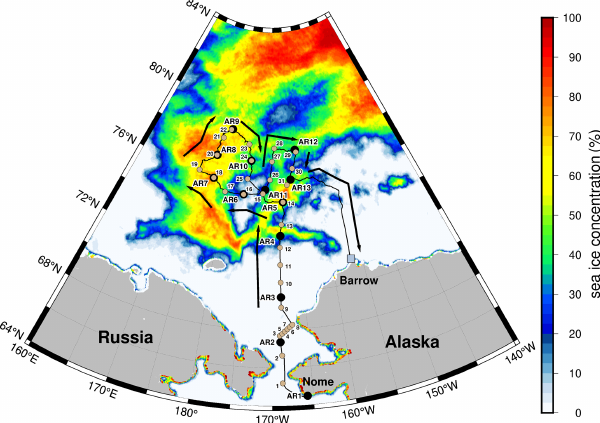
Figure 1. Cruise track (thin black lines) of ARA07B with aerosol- (black circles; sample ID: AR1 − AR13) and seawater-sampling (light-brown circles; sample ID: 1–31) locations. Sampling stations were superimposed onto the mean sea ice concentration derived from Advanced Microwave Scanning Radiometer (AMSR) 2 data for August 2016 (Spreen et al., 2008). Each aerosol-sampling start point represents the end of the previous sampling period. Thick black arrows indicate the moving direction of the